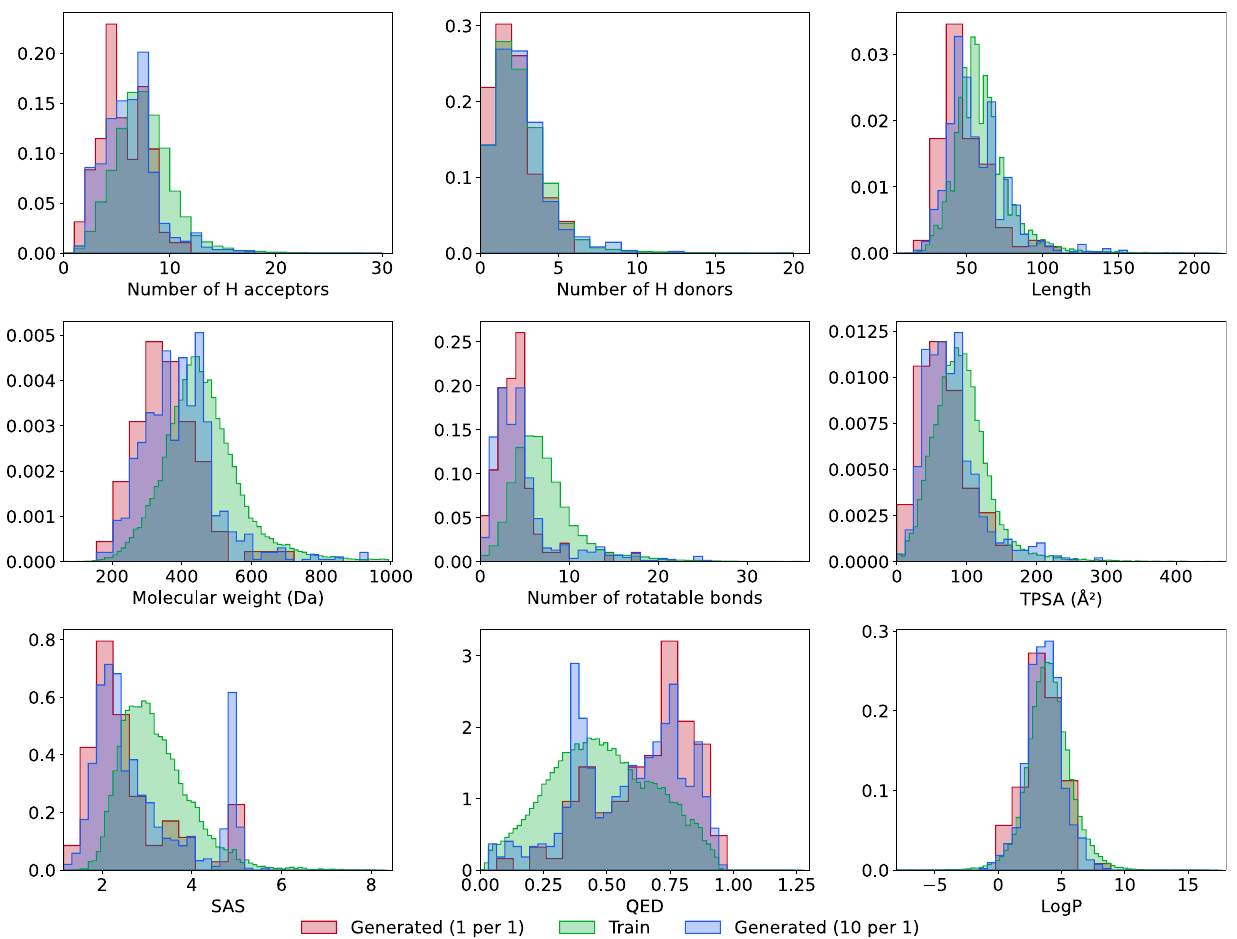
Figure 5. Distribution of properties for the generated molecules. Properties include: water-octanol partition coefficient (logP), the number of H-donors, the number of H-acceptors, the number of rotatable bonds, Quantitative Estimation of Drug-likeness (QED), the synthetic accessibility score (SAS), total polar surface area, molecular weight and length.